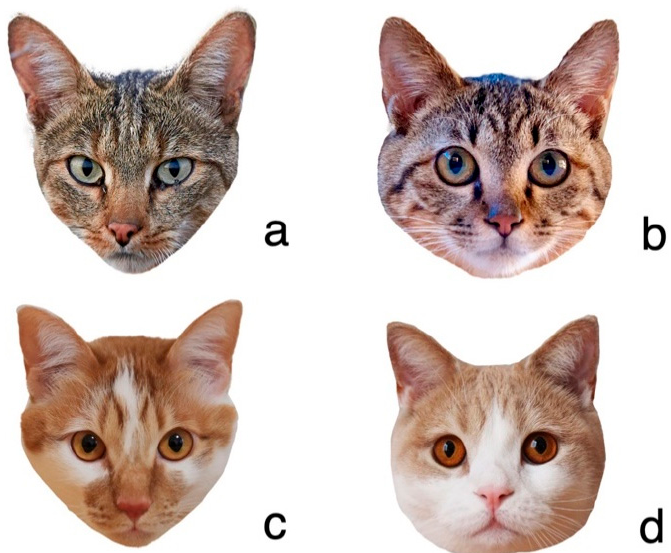
Figure 1. Examples of cat face photos: ( a ) African wildcat ( Felis silvestris lybica ); ( b ) feral mixed breed; ( c ) owned domestic mixed breed; ( d ) owned domestic purebred. Photo credit: ( a ) James Hager/Collection Mix: Subjects/Getty Images; ( b ) Save the Omizunagidori; ( c ) Miso; ( d ) Sakura.